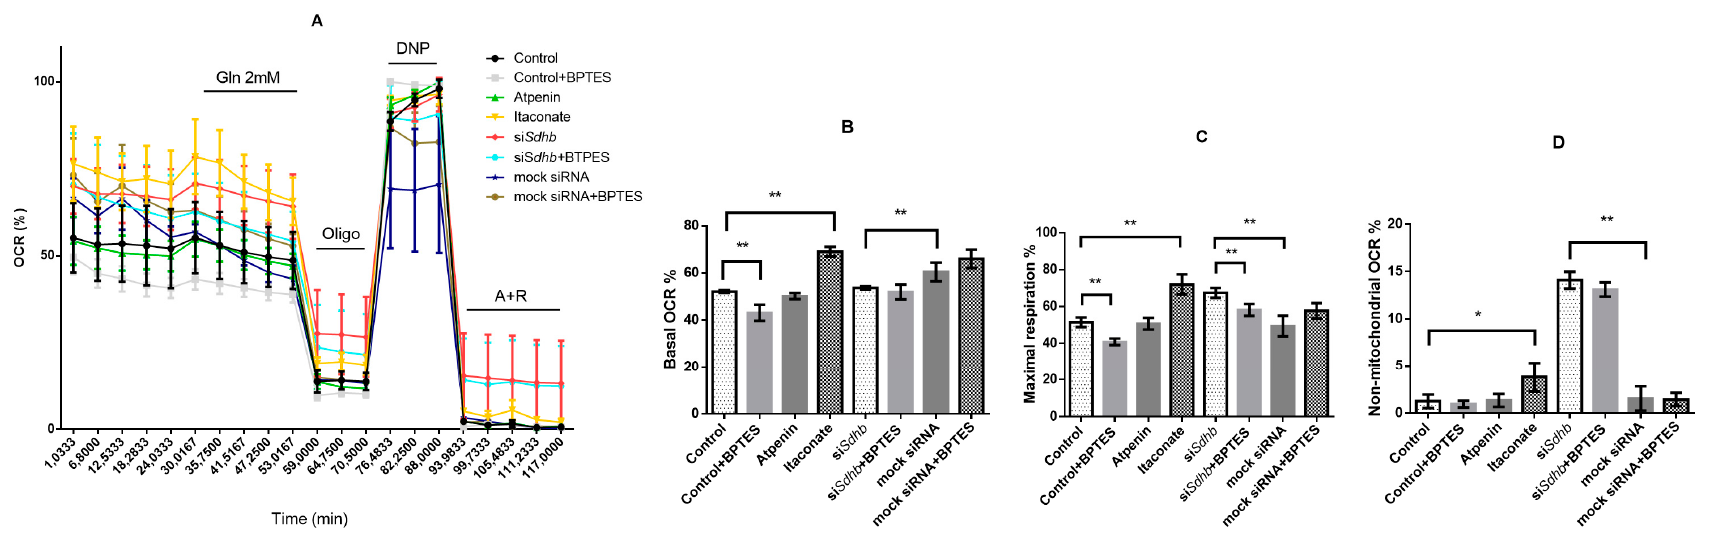
Figure 9. Oxygen consumption measurements of PC12 cells. ( A ). Oxygen consumption ratio (OCR %) of PC12 cells. The minimum value of OCR is 0%, maximum is 100%. ( B ) Basal respiration: subtraction of non-mitochondrial respiration from the baseline respiration. ( C ). Maximal respiration of PC12 cells: difference of OCR after 2,4-dinitrophenol (DNP) and after antimycin A + rotetone (A + R) admission. ( D ) Non-mitochondrial respiration: OCR after inhibition of both complexes I and III with A + R. OCR: oxygen consumption ratio; Gln: glutamine; Oligo: oligomycin; DNP: 2,4-dinitrophenol; A + R: antimycin A + rotetone. *: p < 0.05; **: p < 0.01.